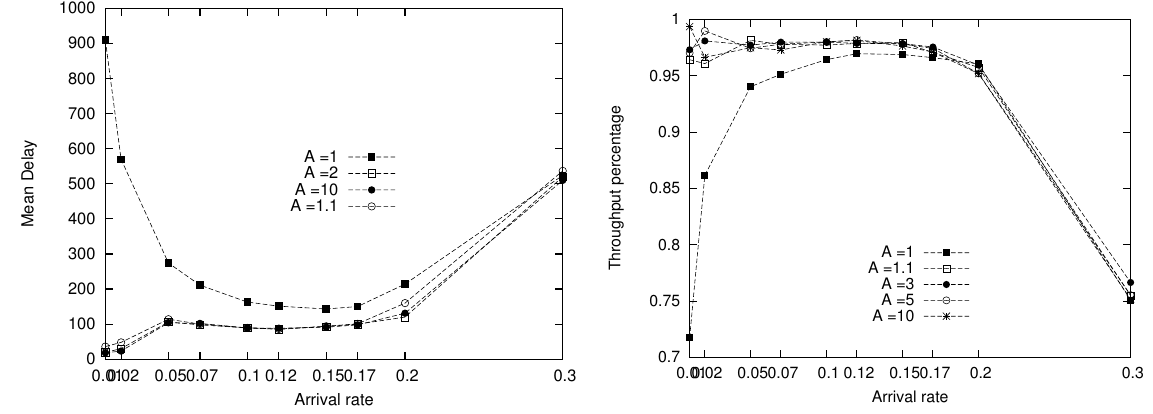
Figure 5. Tuning of parameter A - delay prformance of L ay